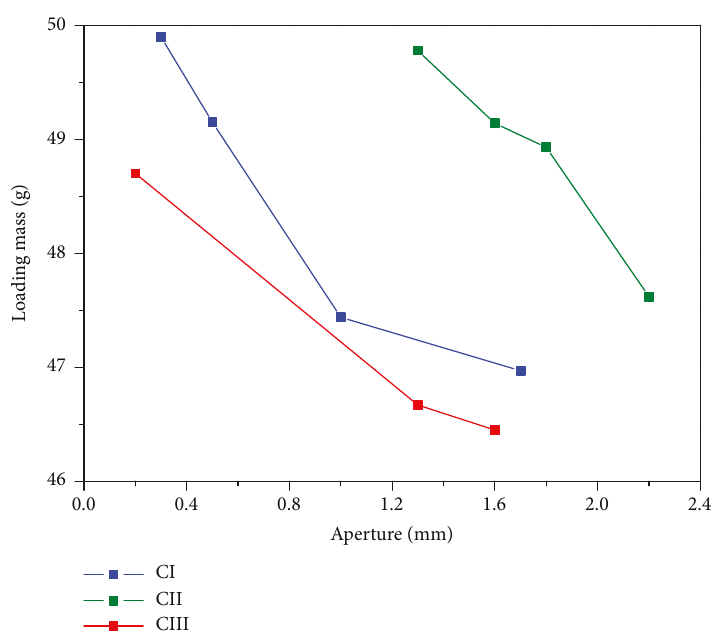
Figure 10: Loading mass at di ff erent apertures.